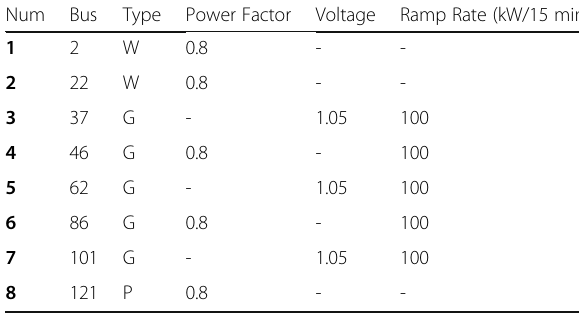
Table 3 Characteristics of the distributed generators Num Bus